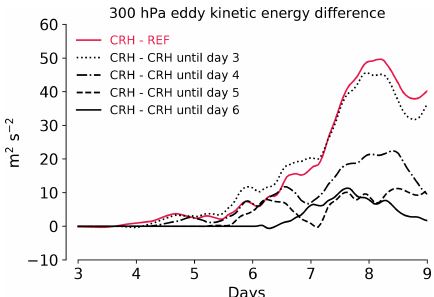
Figure 14. Evolution of eddy kinetic energy differences with re- spect to the CRH simulation at 300hPa for the REF simulation, and simulations with CRH disabled after certain